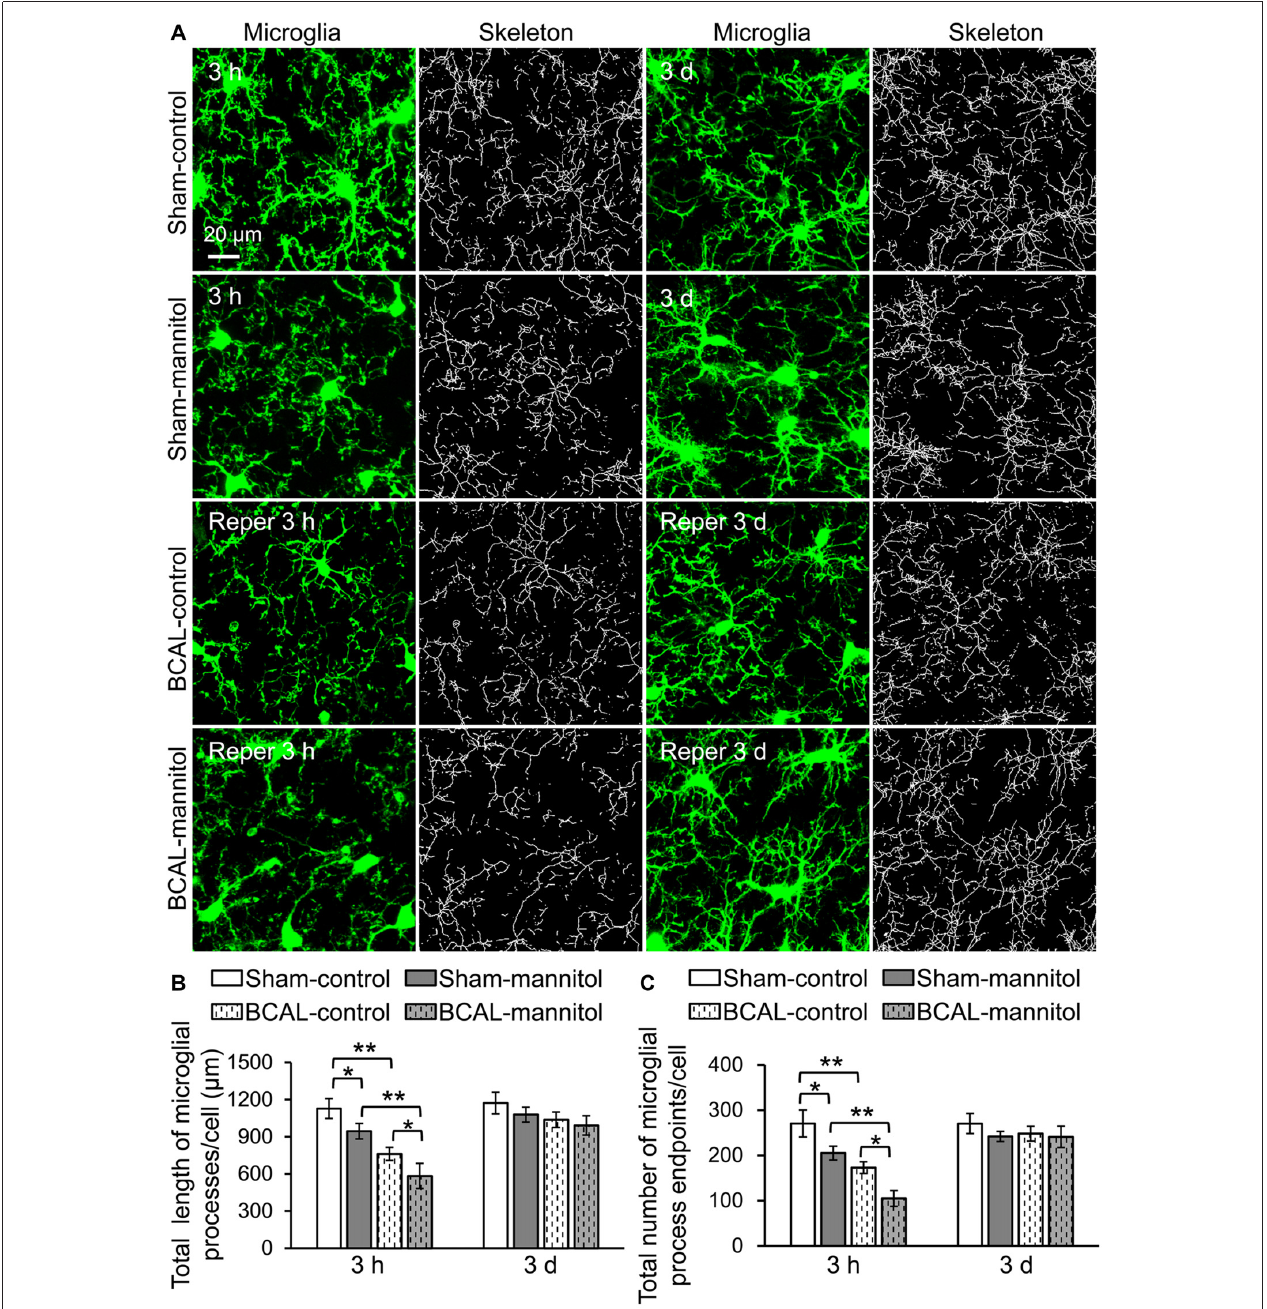
FIGURE 2 | Mannitol-induced rapid morphological change of microglia following reperfusion after transient global cerebral ischemia. (A) Representative confocal images of microglia (green) and skeletonized microglia in sham-control, sham-mannitol, BCAL-control and BCAL-mannitol mice at 3 h and 3 days after ischemia. (B,C) Total length and total number of microglial processes in different groups, respectively. The total length of microglial process per cell and total number of microglial process endpoints at 3 h were significantly reduced after ischemia or mannitol treatment alone, and mannitol treatment in ischemic mice caused further decrease in the total length or total number of microglial process endpoints at 3 h ( n = 6 mice, each group. ∗ p < 0.05 and ∗∗ p < 0.01). However, there are no significant differences in total length of microglial processes per cell or total number of microglial process endpoints per cell in different groups at 3 days ( n = 6 mice, each group. p >